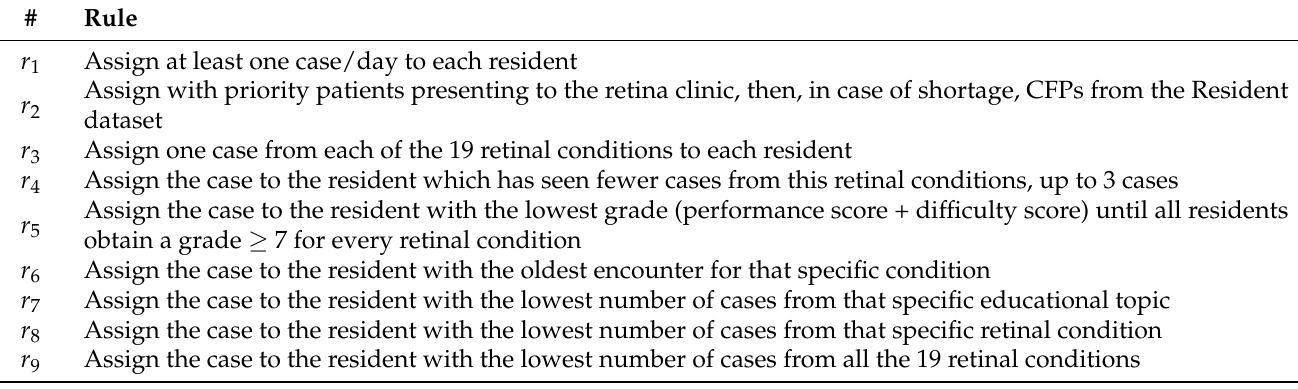
Table 7. Assignment rules for real cases with a diagnosis contained in the 19 RCs.